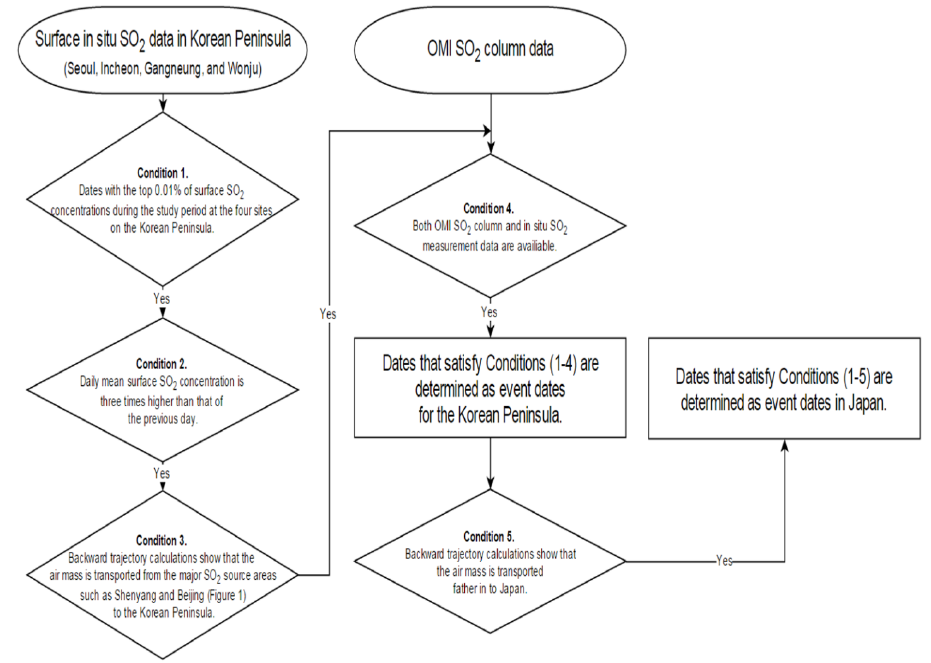
Figure 2. Flowchart for the determination of high SO 2 event dates over the Korean Peninsula and Japan.